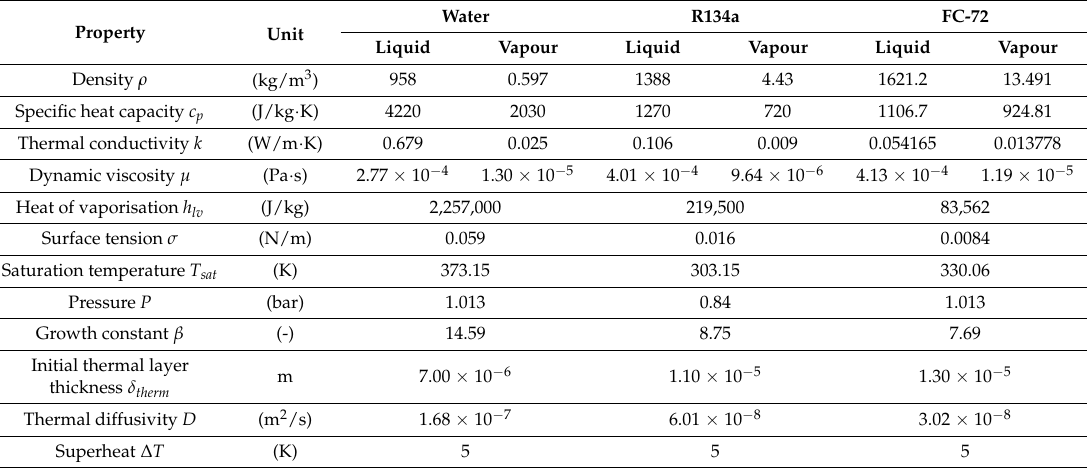
Figure 4. Initial conditions for the water liquid/vapour: P = 1.013 bar, 5 K of liquid superheat. Table 1. Material properties and initial conditions for the numerical simulations (validation